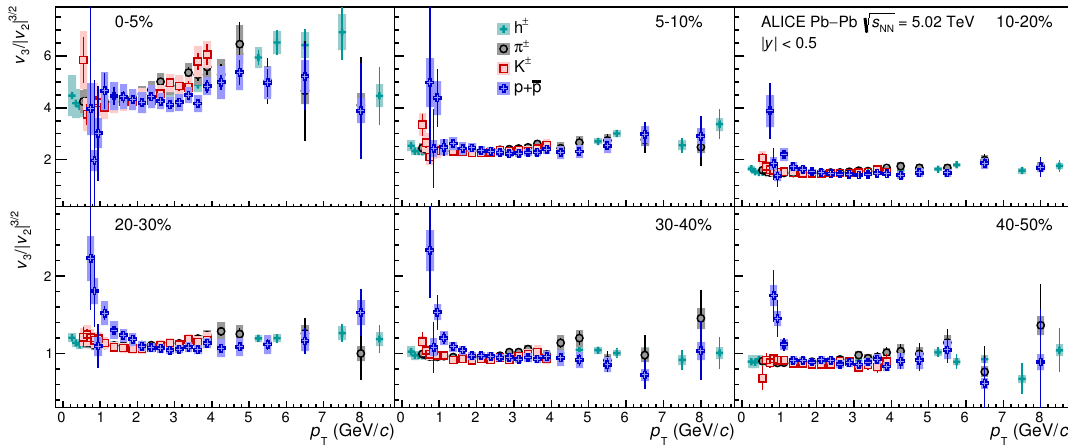
Figure 20 . (Colour online) Centrality dependence of v 3 = j v 2 j 3 = 2 for inclusive charged particles [44], (cid:25) (cid:6) , K (cid:6) , and p+p. Statistical and systematic uncertainties are shown as bars and boxes, respectively.